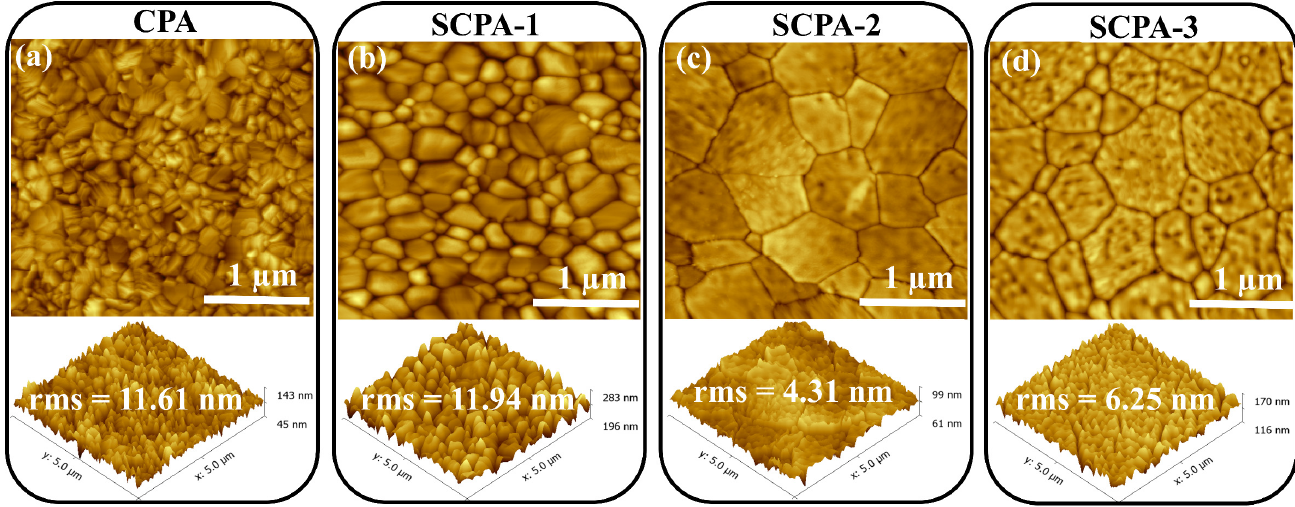
Figure 3. AFM images with rms values of the as-prepared perovskite thin-films with CPA ( a ) and SCPA ( b – d ). SCPA ( b – d